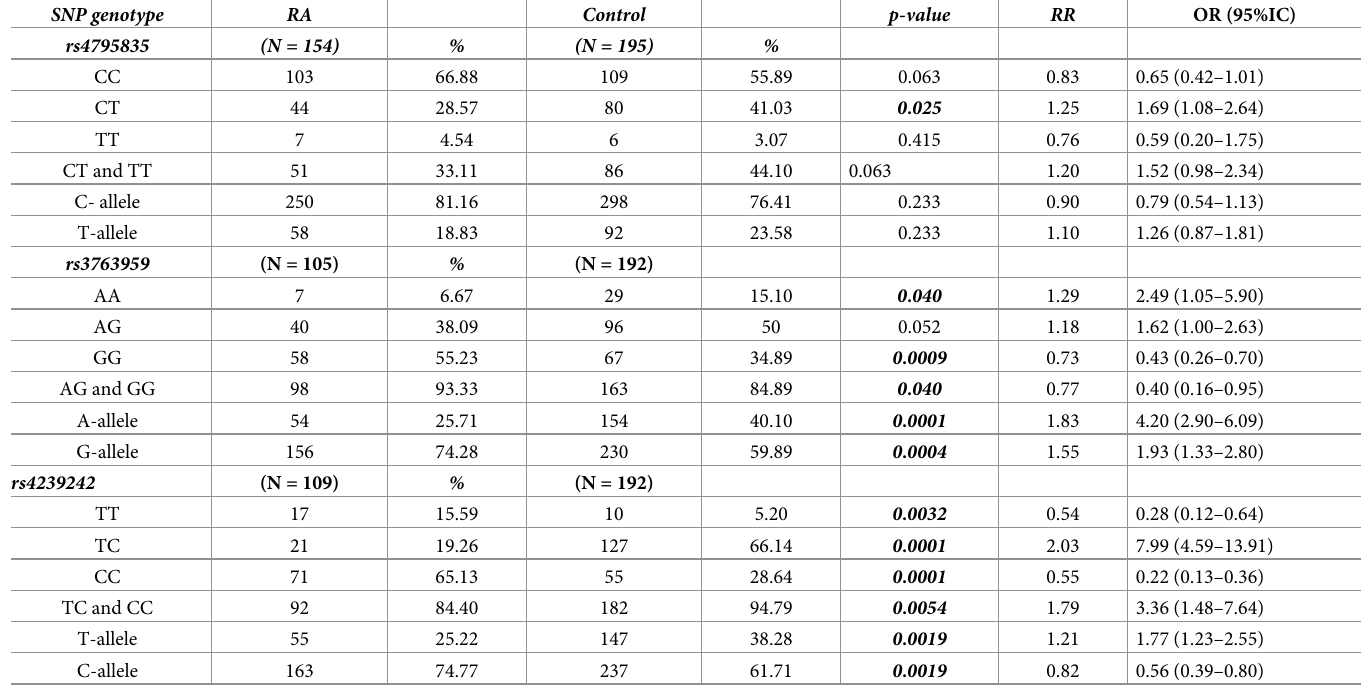
Table 2. Distribution of the LGALS9 alleles and genotypes in patients with RA and healthy individuals. SNP